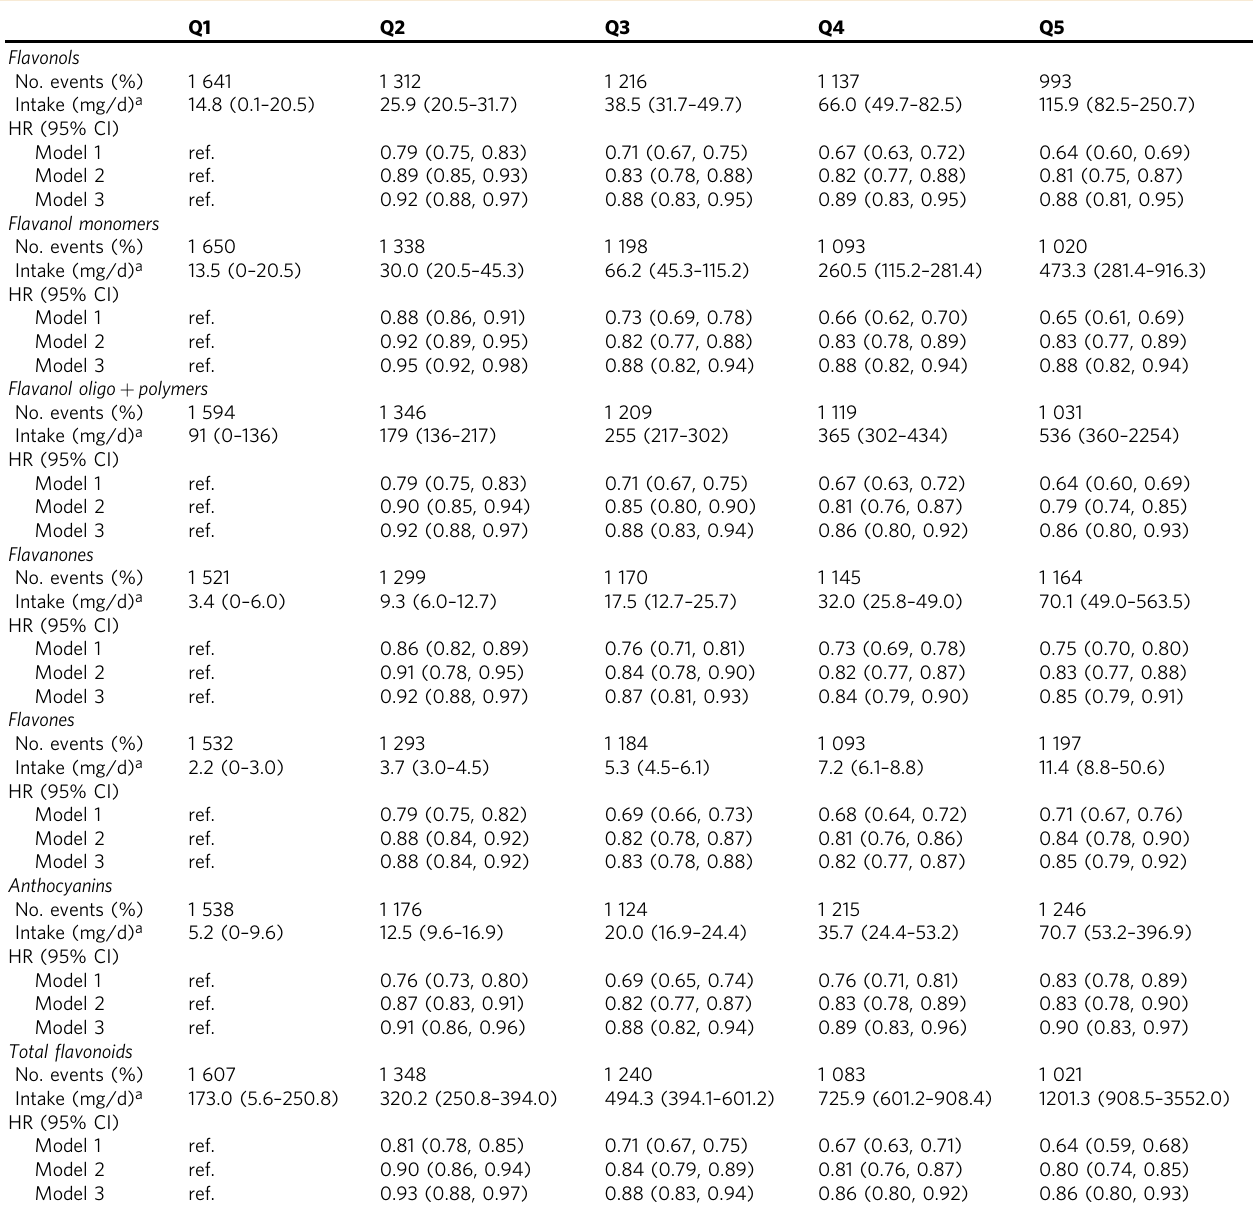
Hazard ratios (95% CI) for 23-year cancer-related mortality, in participants without cancer at baseline ( n = 55 801), obtained from restricted cubic splines based on Cox proportional hazards models. Model1adjustedforageandsex;Model2adjustedforage,sex,BMI,smokingstatus,physicalactivity,alcoholintake,hypertension,hypercholesterolemia,socialeconomicstatus(income),diabetes,and prevalent disease; Model 3 adjusted for all covariates in Model 2 plus intakes of fi sh, red meat, processed meat, dietary fi ber, polyunsaturated fatty acids, monounsaturated fatty acids, and saturated fatty acids a Median; range in parentheses (all such